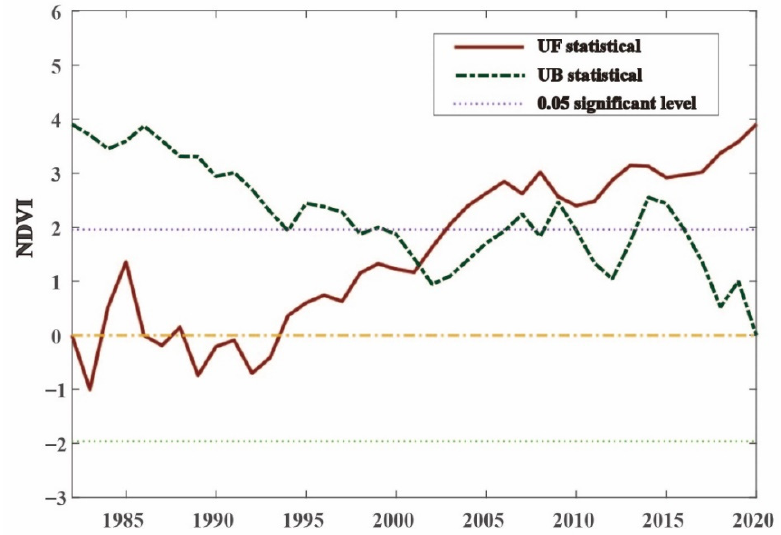
Figure 7. Mutation analysis of NDVI in Inner Mongolia from 1982 to 2020.